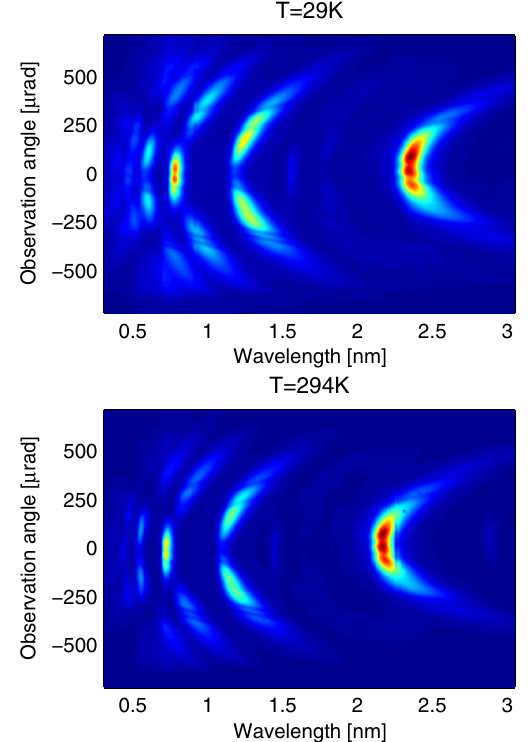
FIG. 5. CCD data from the TGS. The images compare the cooled case with the RT case. The entrance slit sizes 75 μ m and 100 μ m were adapted to optimize the resolution of the spec- trometer for the specific wavelength of the first harmonic — see the Appendix. The color scale is normalized to the maximum count number of the fundamental peak. Shadows of the grating ’ s support structure [19] are visible.